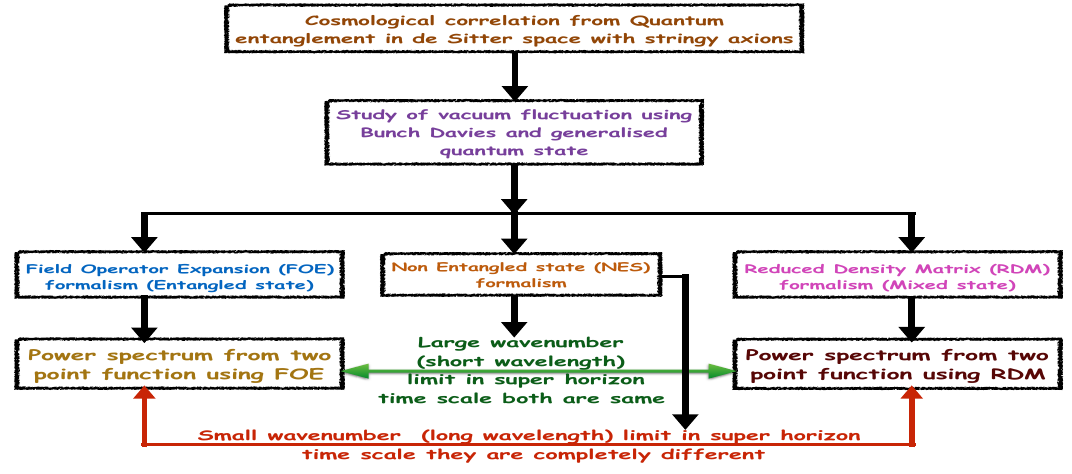
Figure 1. Schematic diagram for the computation algorithm of long range effect of cosmological correlation function from quantum entanglement of axion in de Sitter open hyperbolic